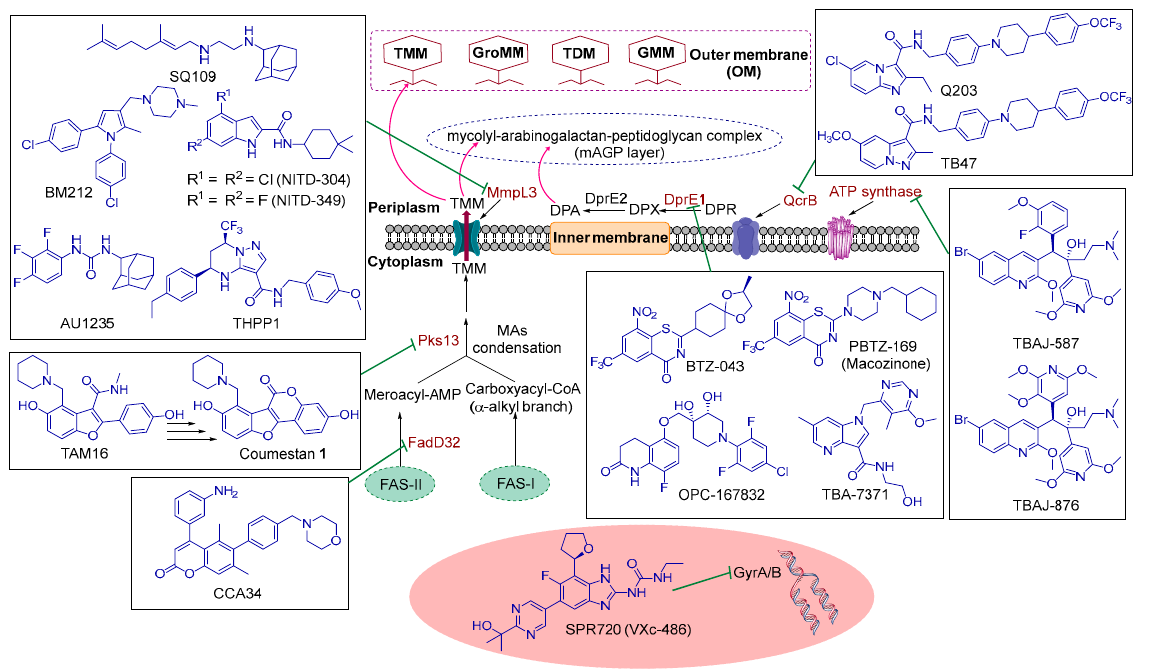
Figure 6. Schematic representation of the site of action of several current promising anti-TB drug candidates and hit/lead compounds. A simple version of the mycobacterial cell wall and the cytoplasmic membrane is portrayed, showing the current hot targets in TB drug discovery, namely GyrA/B, QcrB, ATP synthase, DprE1, FadD32, Pks13 and MmpL3. TMM: trehalose monomycolate, GroMM: glycerol monomycolate, TDM: trehalose dimycolate, GMM: glucose monomycolate (GMM), DPR: decaprenylphosphoryl-D-ribose, DPX: decaprenylphosphoryl-2 ′ -ketoribose, DPA: decaprenylphosphoryl-D-arabinose, MAs: mycolic acids, FAS-I: fatty acid synthase I and FAS-II: fatty acid synthase II.